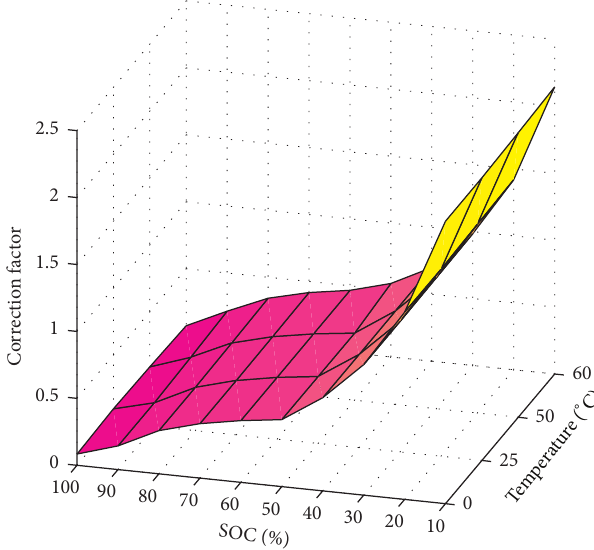
Figure 1: Correction factor variation with temperature and